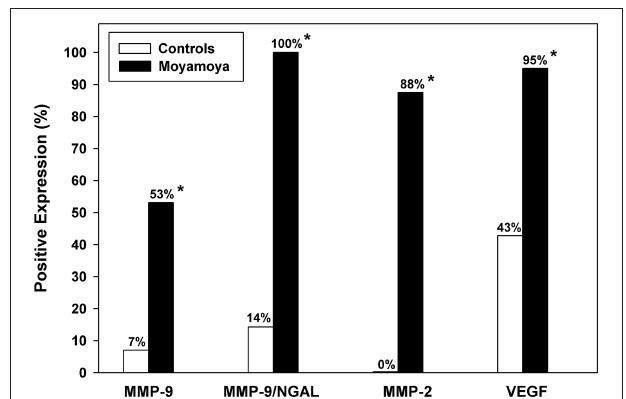
FIGURE 1 | Comparison of the percentage of moyamoya disease patients and controls with positive expression for urinary MMPs and VEGF. Significantly higher positive expression rates were observed for each biomarker as denoted by asterisks. The most useful biomarker according to both multivariable logistic regression and ROC analysis was MMP-2 demonstrating excellent predictive